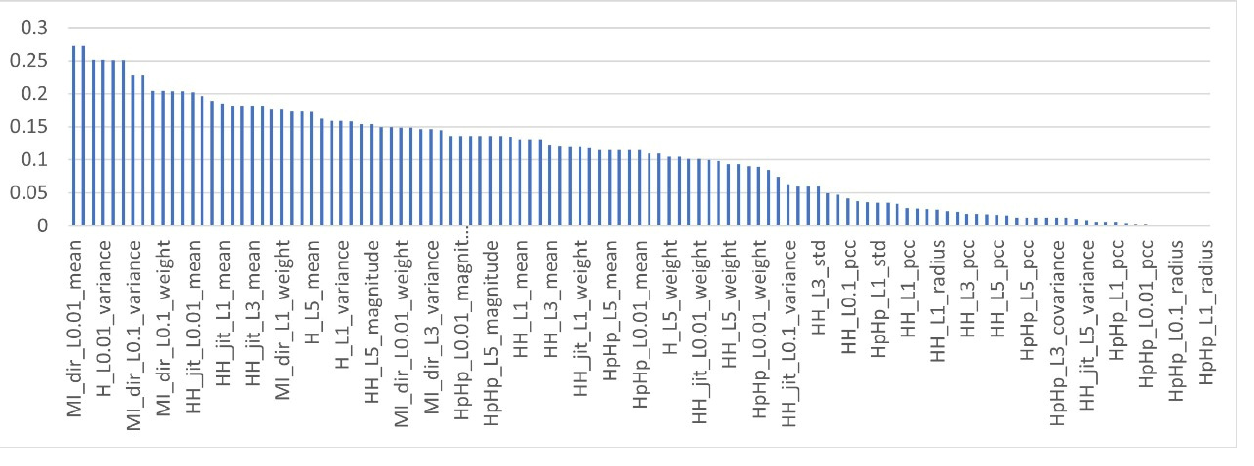
Figure 6. Sorted mutual information of Features with AVERAGE aggregation function. Table 8. Top 10% of Selected Features: The features are sorted in descending order with respect to MI